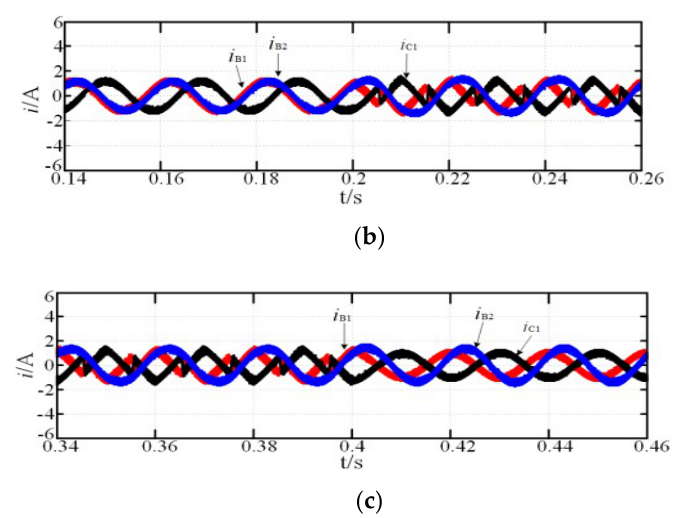
Figure 6. Simulation of fault-tolerant operation: ( a ) MCC; ( b ) magnification of M region; ( c ) magnification of N region.